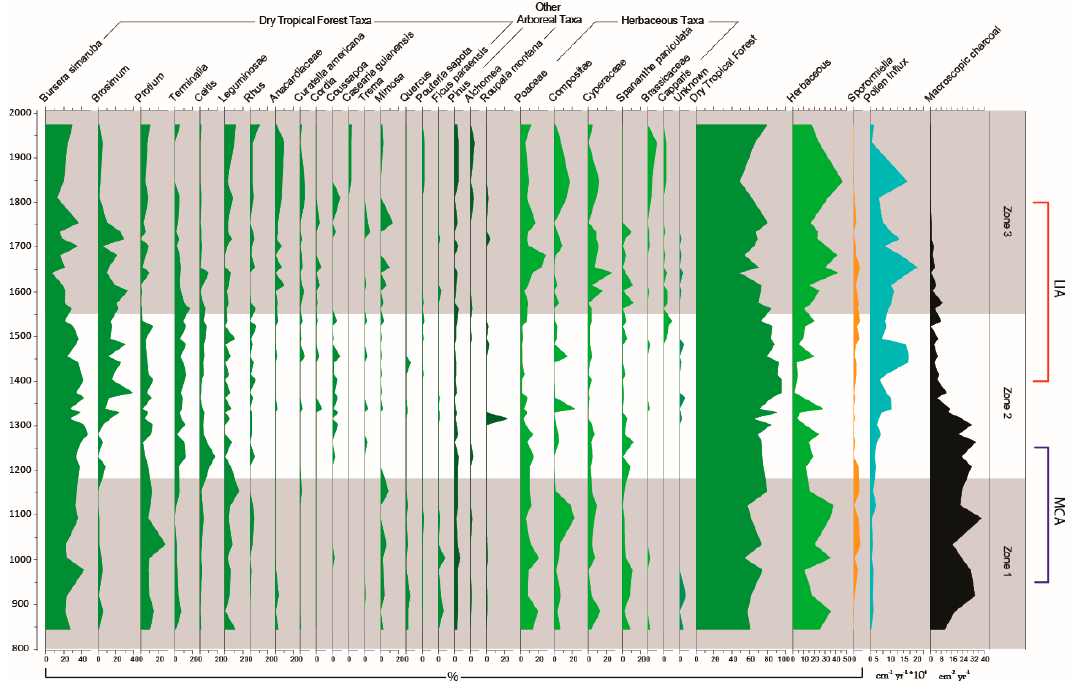
Figure 6. Palynological assemblage, Sporormiella , and macroscopic charcoal reconstructed from El Gancho, Nicaragua.